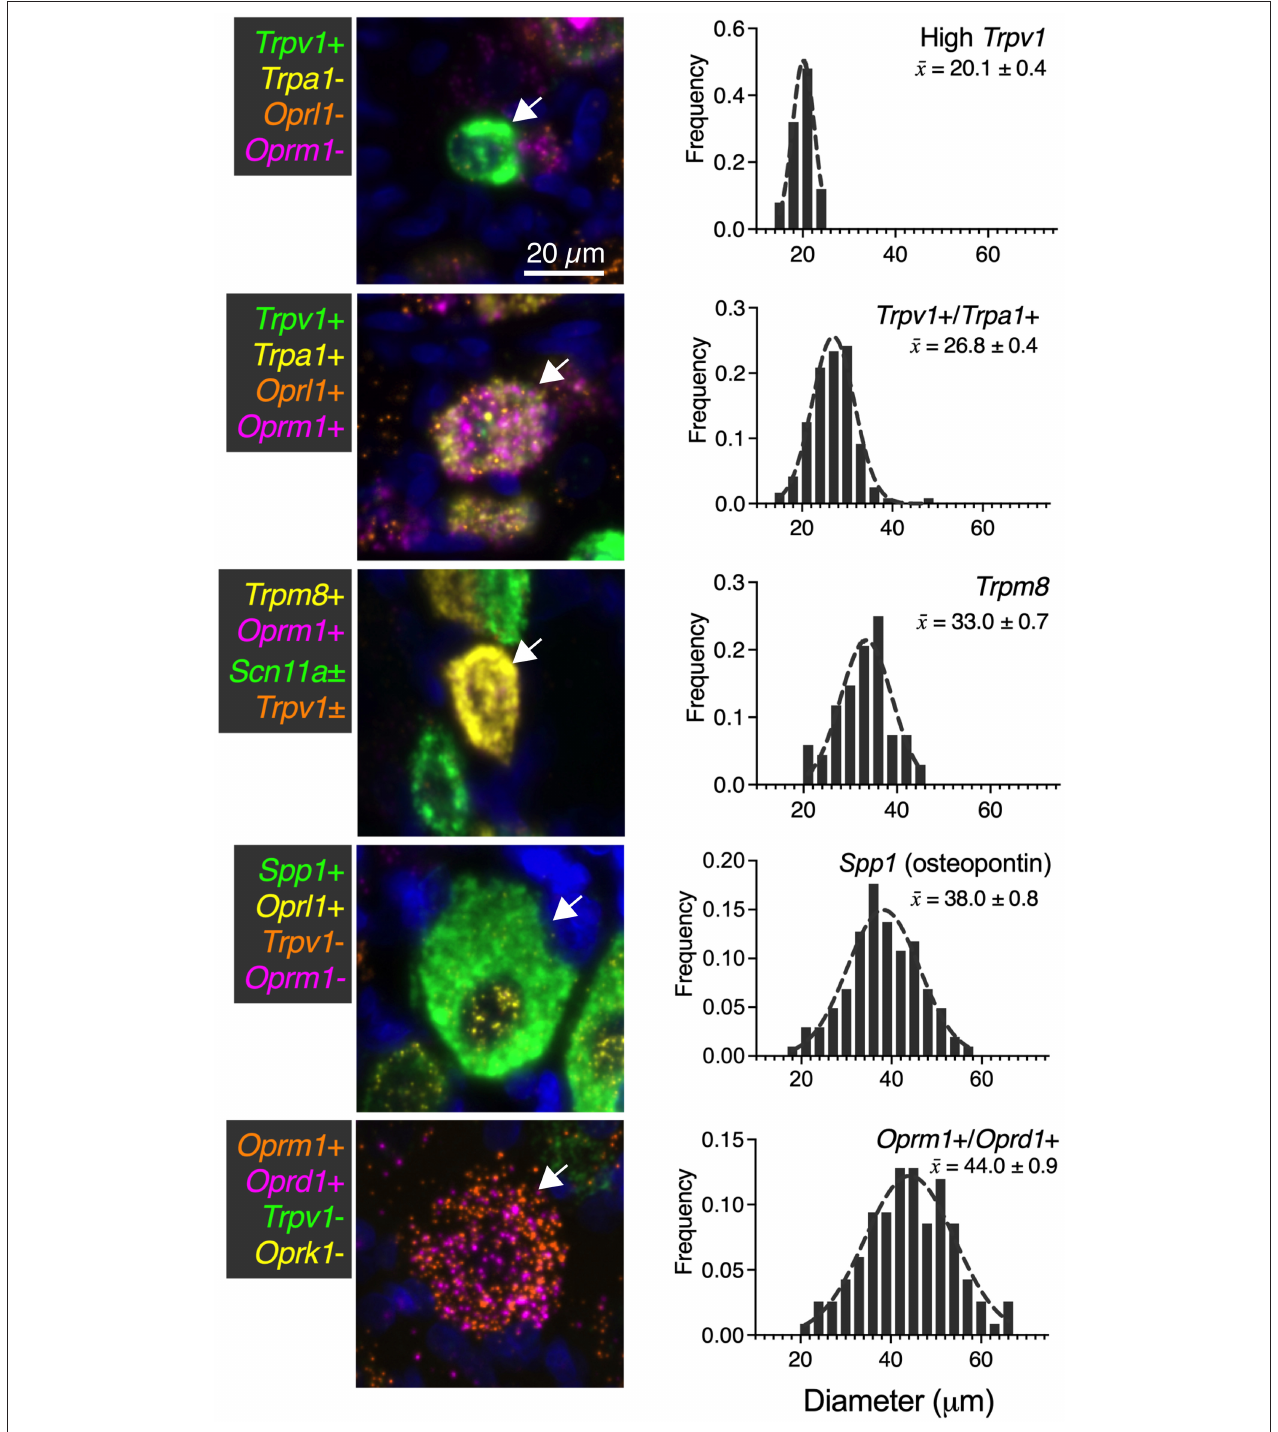
FIGURE 9 | Summary of identified cell types with size analysis. For each of the major identified cell types in the present study, a representative image (66 µ m square) is shown. Additionally, histogram information of the cell size for each population is identified in ascending order of mean size smallest cells (20.1 µ m 0.4). Oprm1 / Oprd1 neurons were the largest cells identified, with an average size of 44.0 µ m ± + + These analyses were performed with at least N 3 =